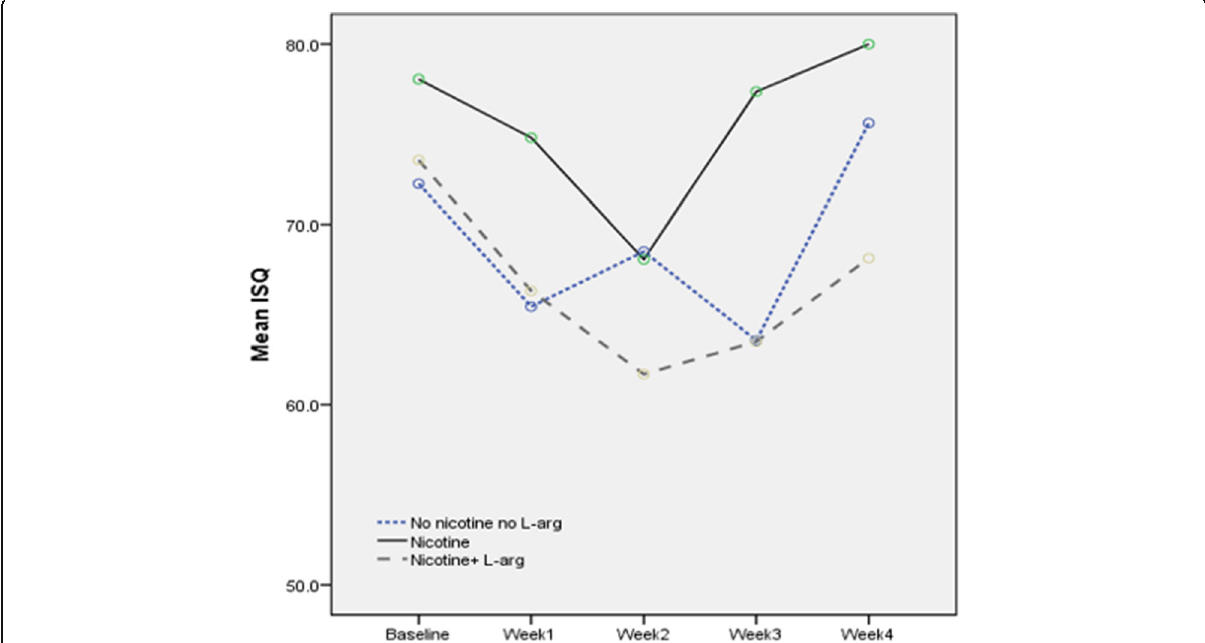
Fig. 4 The mean ISQ was measured every week for 4 weeks in the three study